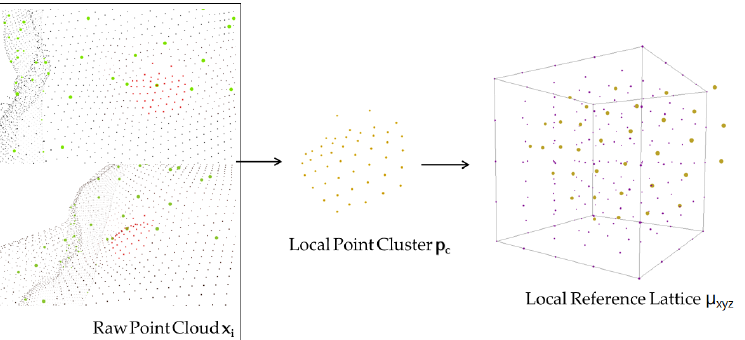
Figure 2. From left to right: a neighboring point cluster has been extracted from the raw point cloud (points in red), from the centroid of which a local reference lattice is constructed for further